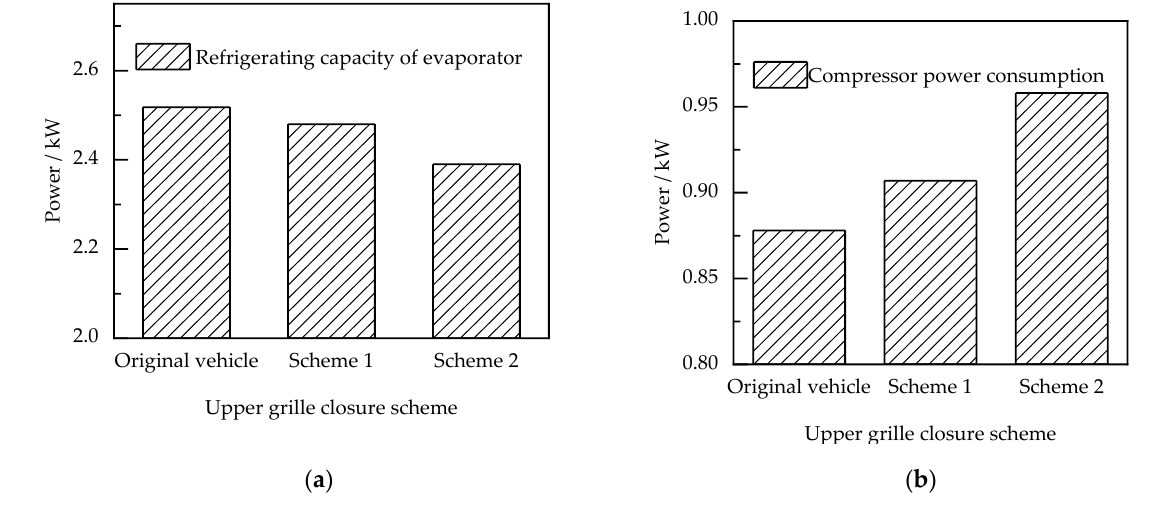
Figure 19. Comparisons of cooling capacity and power consumption of the air conditioning system under different schemes: ( a ) comparison of refrigerating capacity; ( b ) comparison of power con- sumption. 4.1.4. Summary and Analysis This section summarizes the performance changes of the vehicle cooling system un- der the climbing condition and air conditioning under idling condition, as well as the air resistance coefficient. The specific results are shown in Table 7. For scheme 2, the drag coefficient was only 1.5 counts lower than that of scheme 1, but the allowable ambient temperature was reduced by 5.4%, that is, the cooling capacity was greatly affected in scheme 2. To sum up, on the basis of scheme 1, the lower grille continues to be improved.